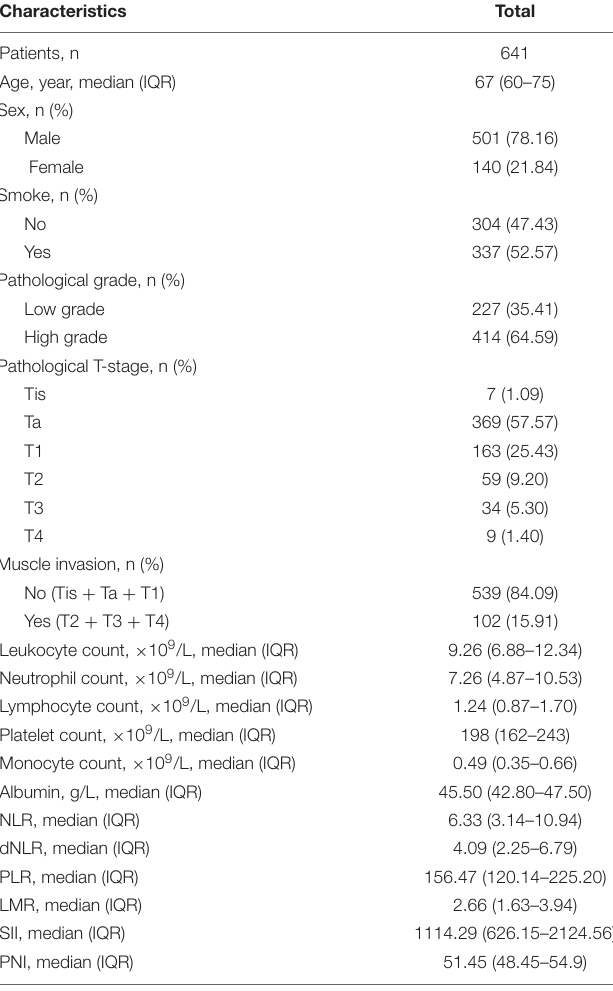
TABLE 1 | Patients’